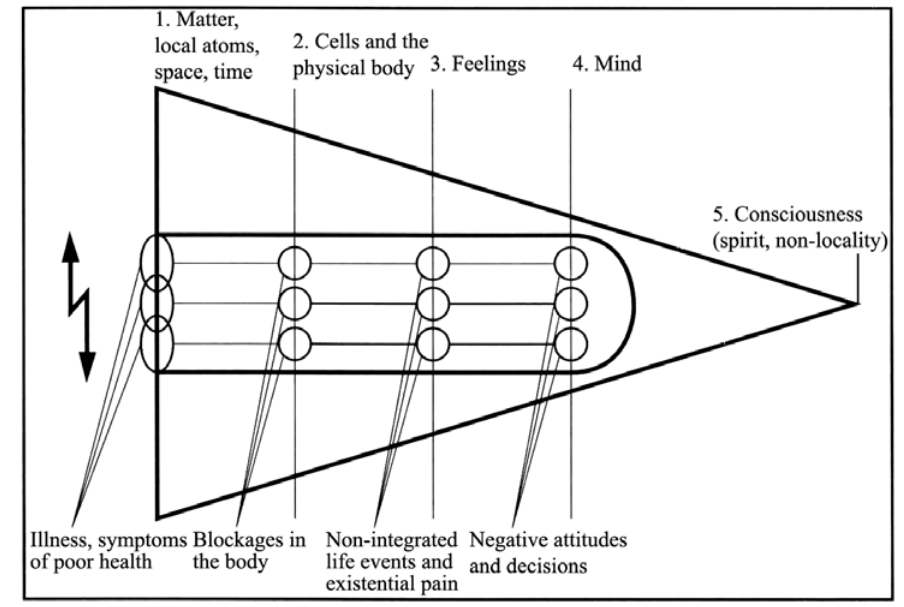
FIGURE 1. The holistic process theory of healing can be divided in three steps: “to feel, to understand, and to let go”. “To feel” is to set feelings on the body, “to understand” is to set words on the feelings, and “to let go” is to set consciousness on the words. During these three steps, the illness and suffering is treated causally, as the etiology seen from the holistic perspective is the “blockages” in mind and body. The blockages are caused by feelings, suppressed by negative decisions into the tissues of the body. In the optimal process of holistic healing, the three above- mentioned steps occur at the same